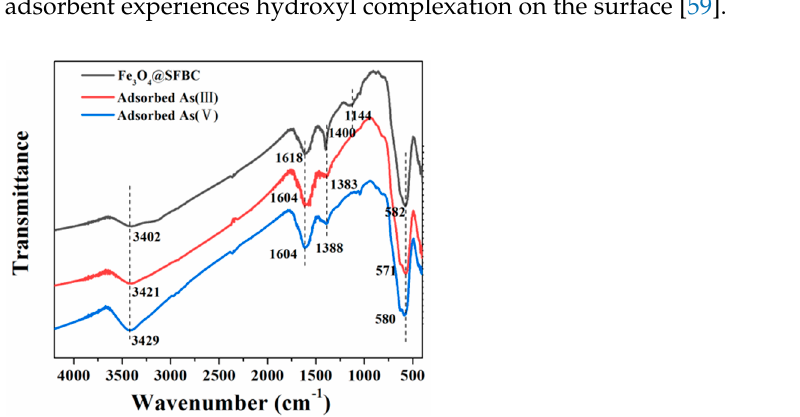
Figure 13. FTIR spectra of Fe 3 O 4 @SFBC before and after the adsorption of As(III/V).